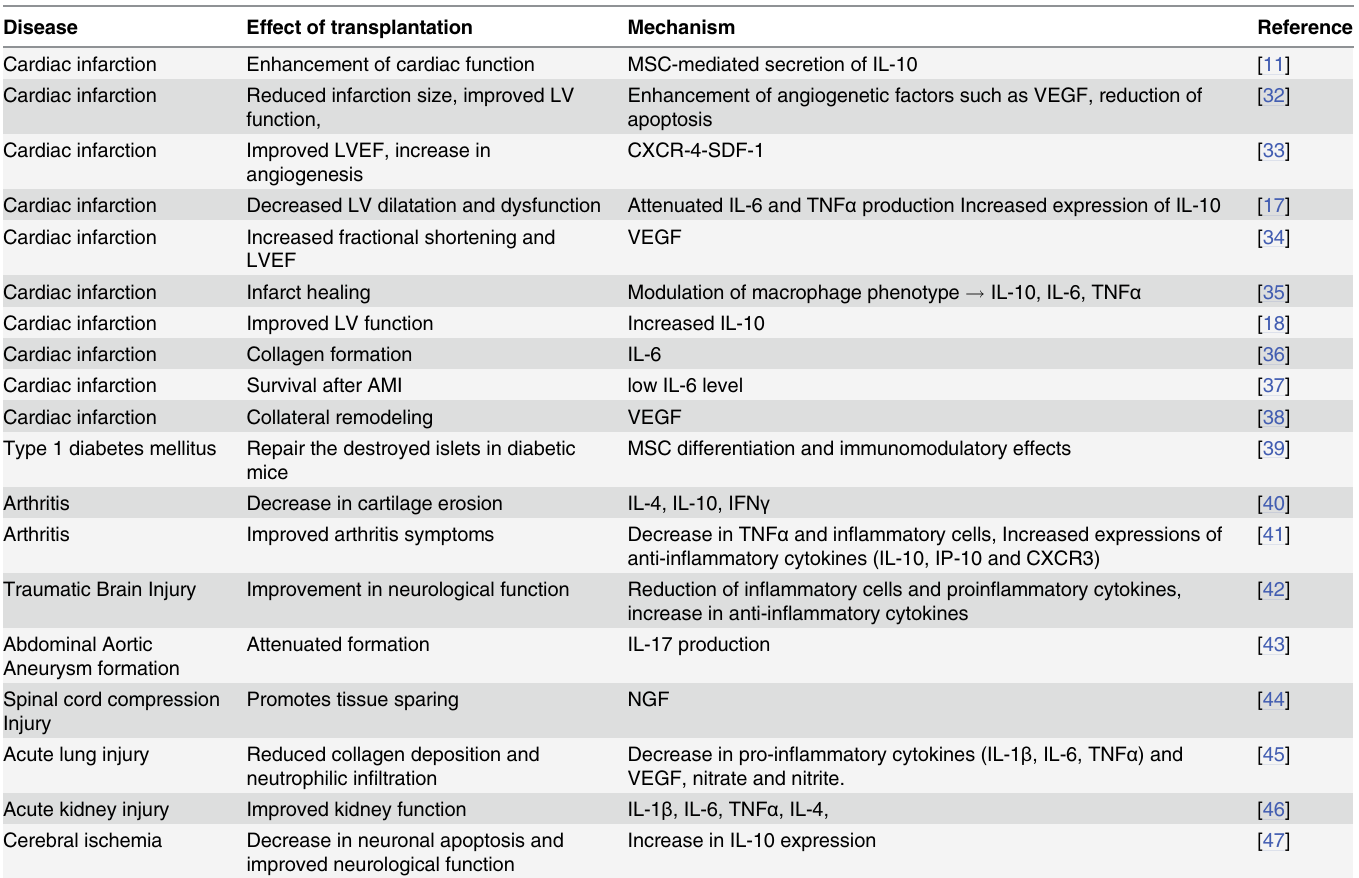
Table 1. BMMNC and mesenchymal stem cells in various